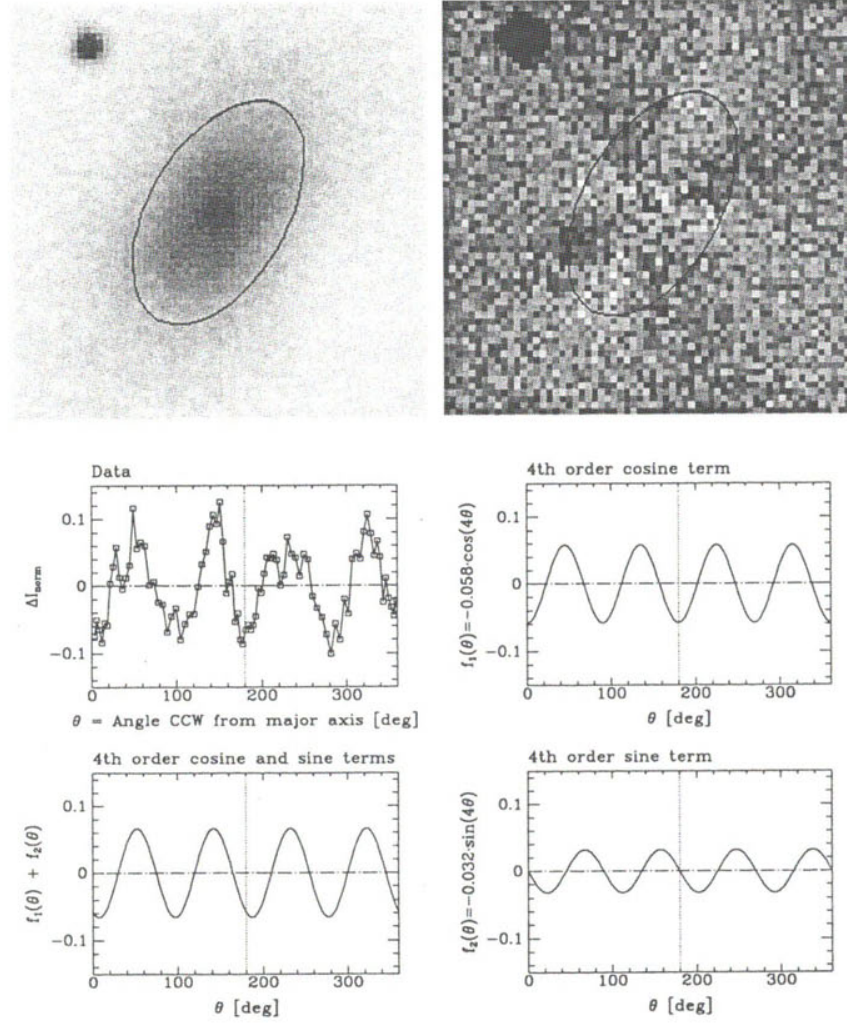
Fig. 7. Top: Original and residual images of the boxy galaxy, with a single ellipse at a = 3.8 kpc (r = 2.8kpc) shown. The images are 13 kpc on the side. The 'Data' plot shows A/ norm versus 0 along the shown ellipse.